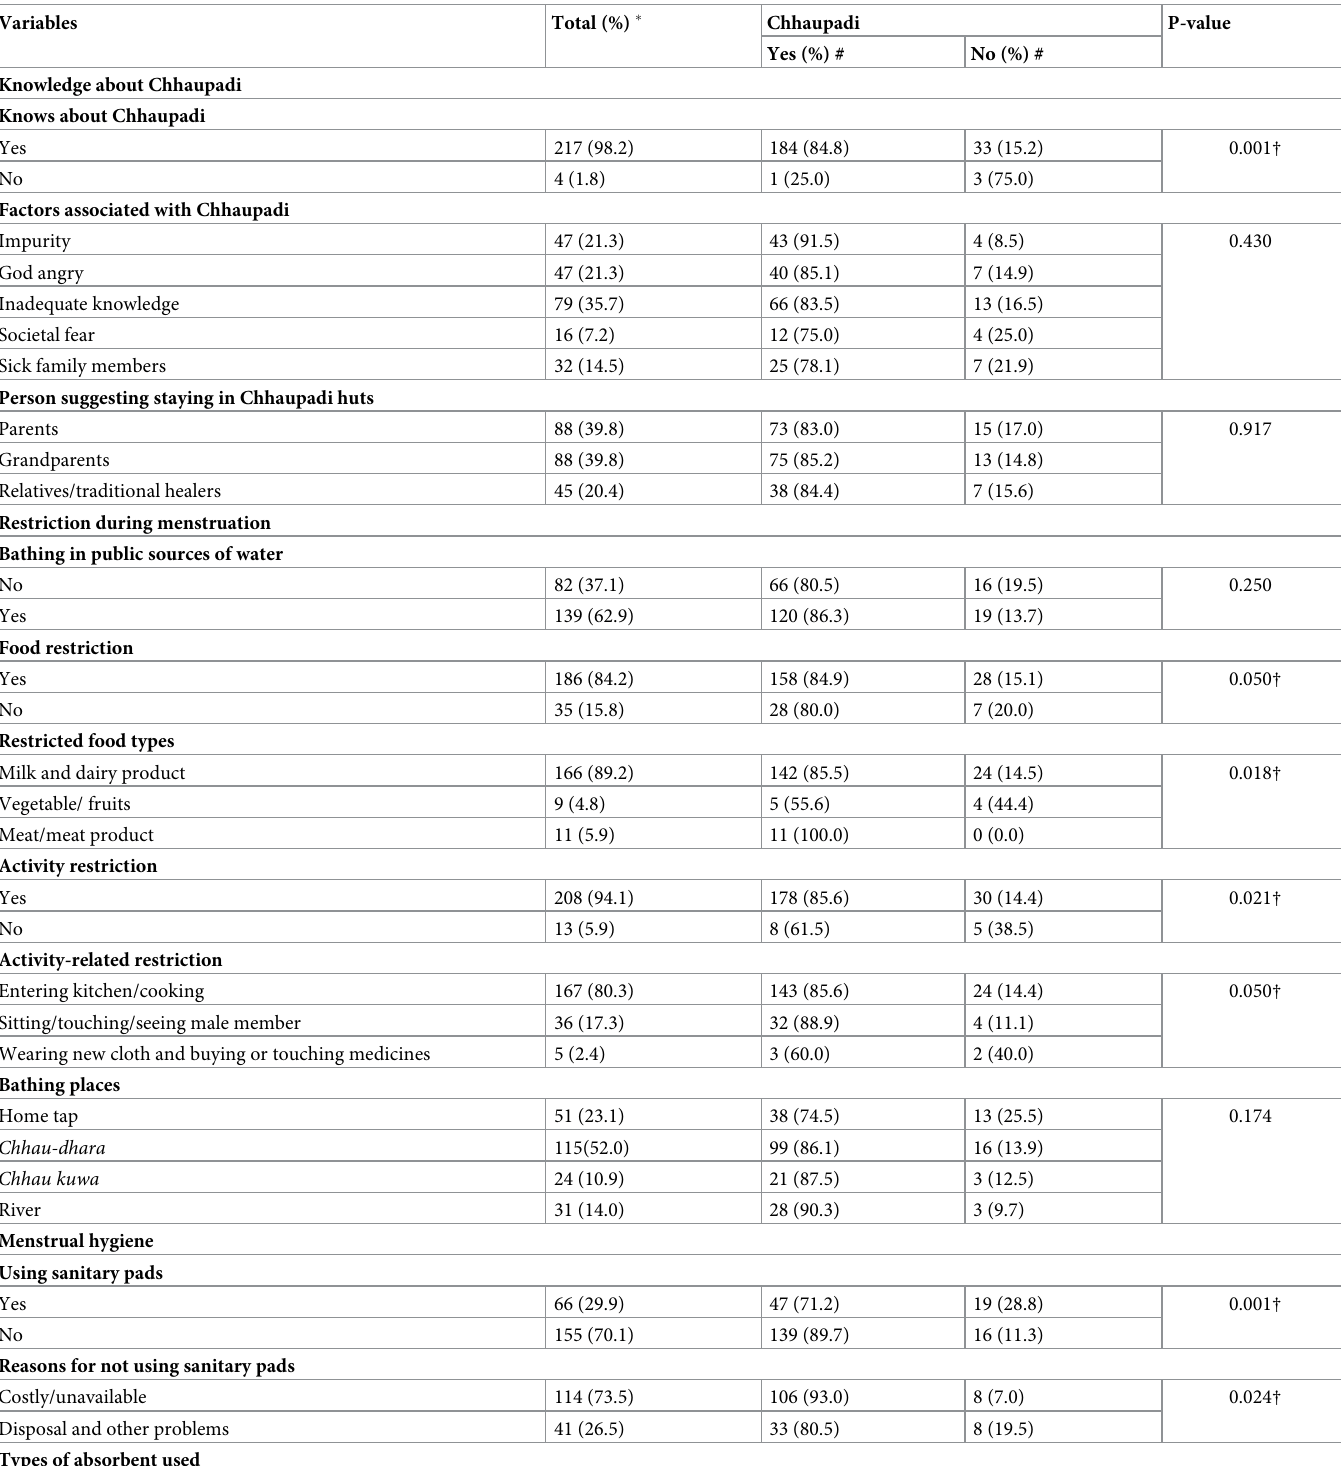
Table 2. Knowledge, restrictions, and hygiene practice among adolescent girls in their most recent menstrual period in Mangalsen municipality, Achham district,